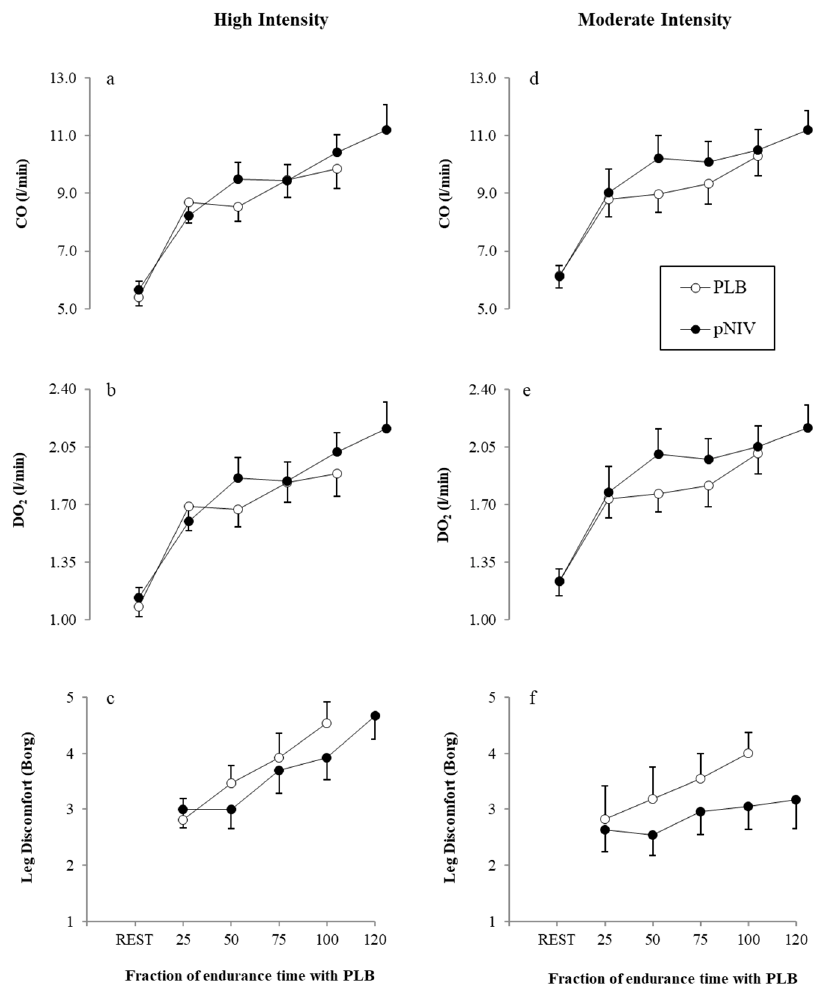
Figure 5. Effect of the application of pNIV (closed circles) compared to PLB (open circles) on cardiac output (CO: a , d ), estimated systemic oxygen delivery (DO 2 : b , e ) and symptoms of leg discomfort ( c , f ) during high- and moderate-intensity exercise protocols, respectively. Responses are shown for both PLB and pNIV at iso-time across the four percentiles (25%, 50%, 75% and 100%) of the total endurance time when using the PLB technique. Data are presented as mean ± SEM.